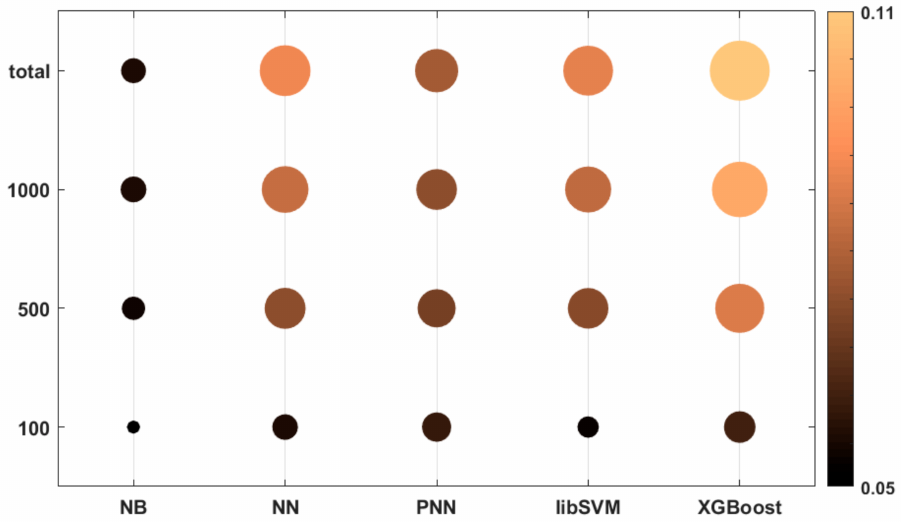
Figure 9. Bubble plot of the performances of the machine learning algorithms at different dataset sizes for Case Study 3. Both the colors and the radii of the circles correspond to the average of the 25 normalized performance parameter values. (The bigger (and brighter) the better.).